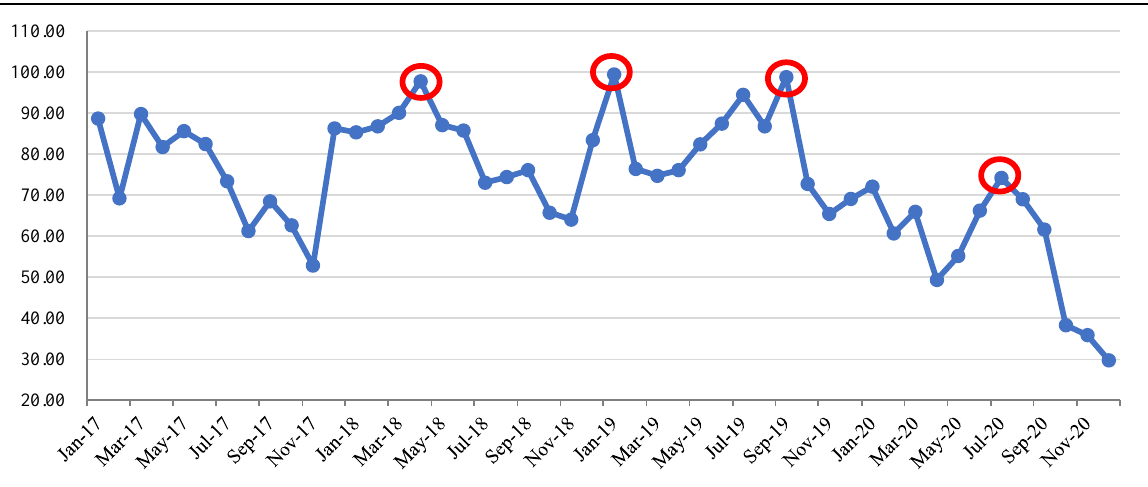
Figure 2. The rate of food poisoning incidence per 100,000 elderly people in Khon Kaen Province at 4 epidemic peaks selected for the model